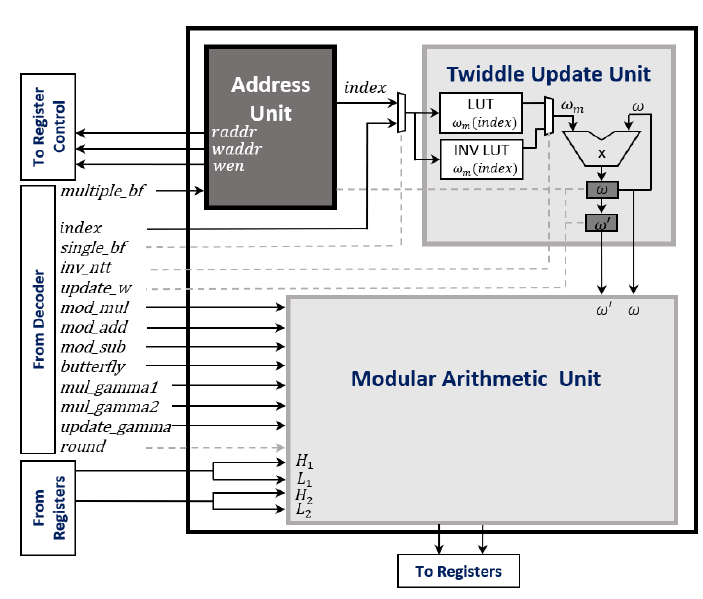
Figure 2: NTT and Modular Arithmetic